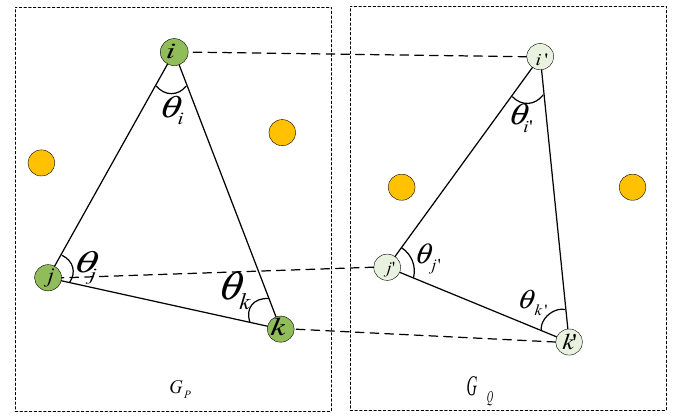
Figure 3. Diagram of the triangle descriptors.